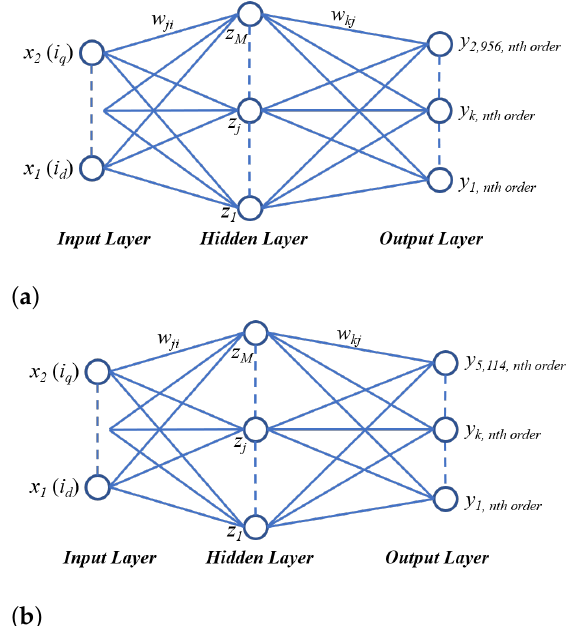
Figure 10. Learning diagram (e.g.,: n th harmonic order) : ( a ) stator. ( b )